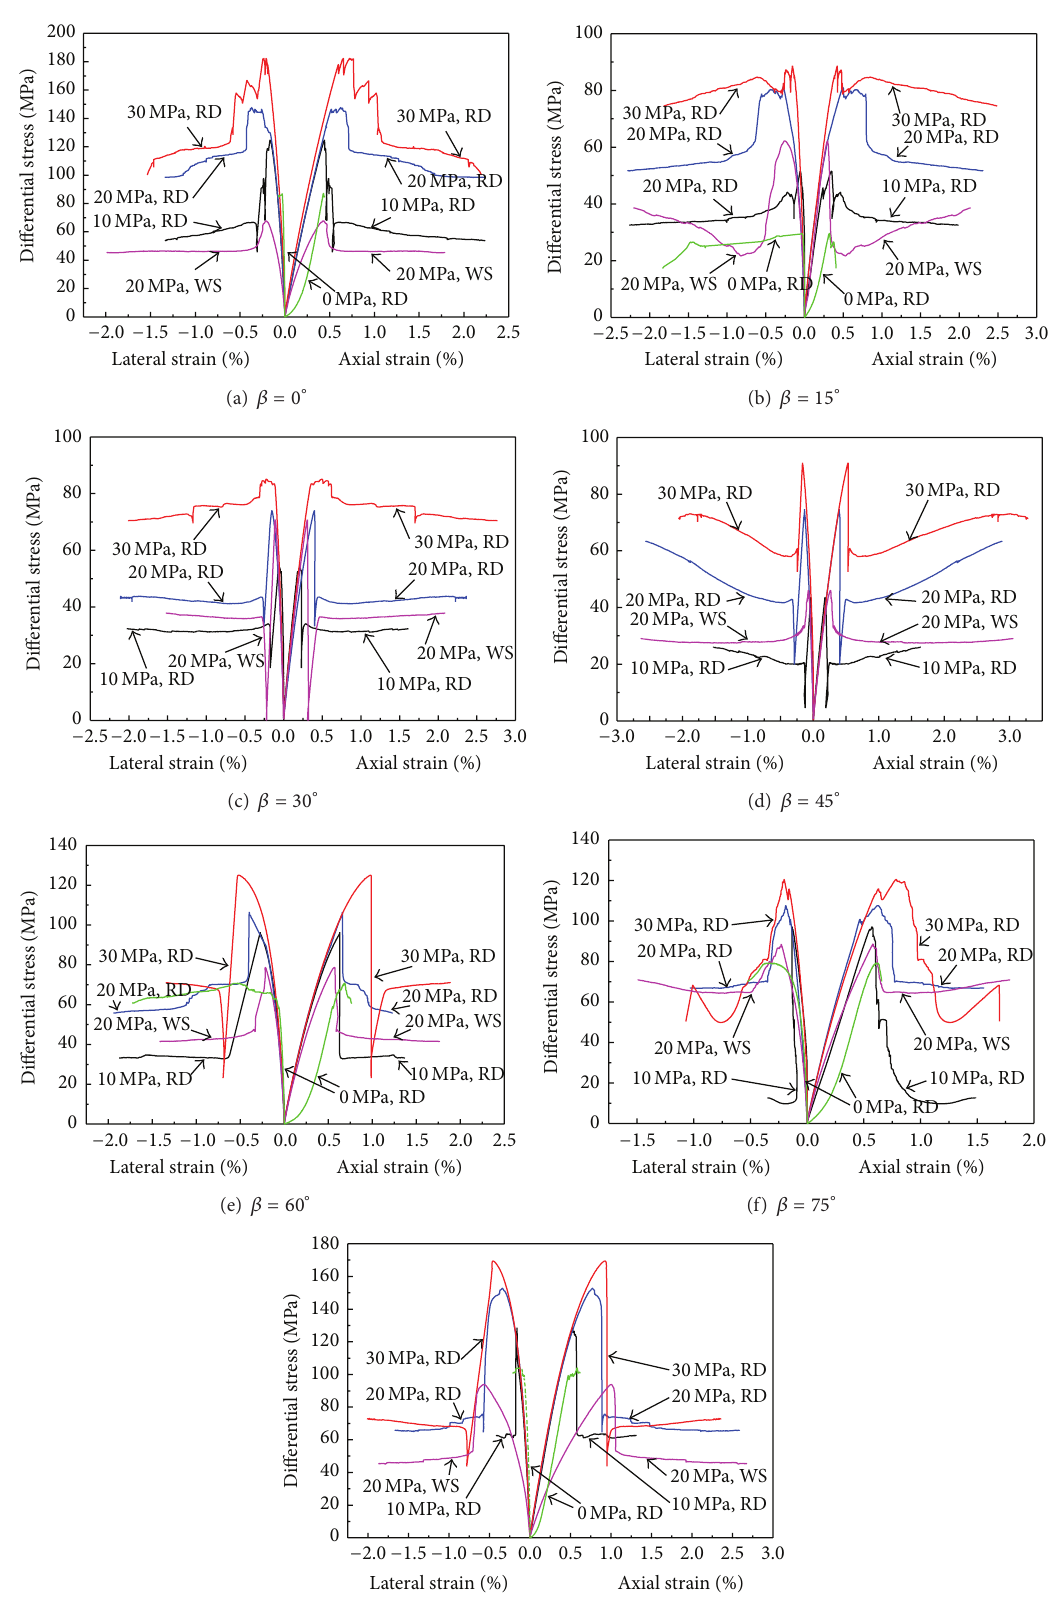
Figure4:Thecompletestress-straincurvesofdryandsaturatedshalesamplesofvariousangles( 𝛽